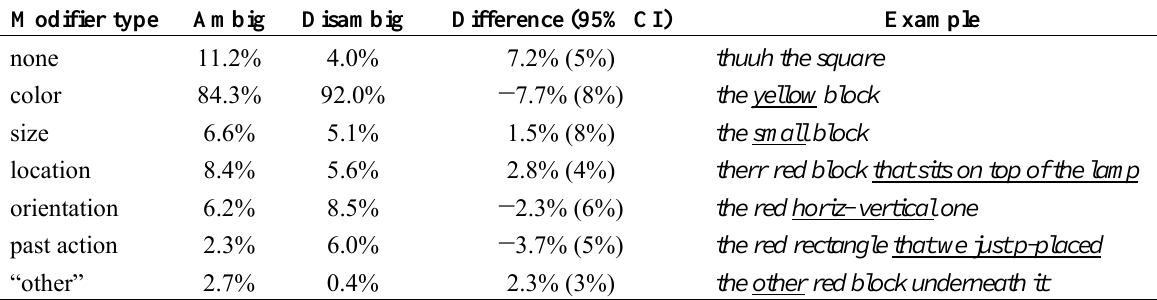
Table 1. Distribution of different modifier types for ambiguous and disambiguated expressions ( n = 989). Percentages sum to more than 100% because many expressions had multiple modifiers. The relevant modifier is underlined in the